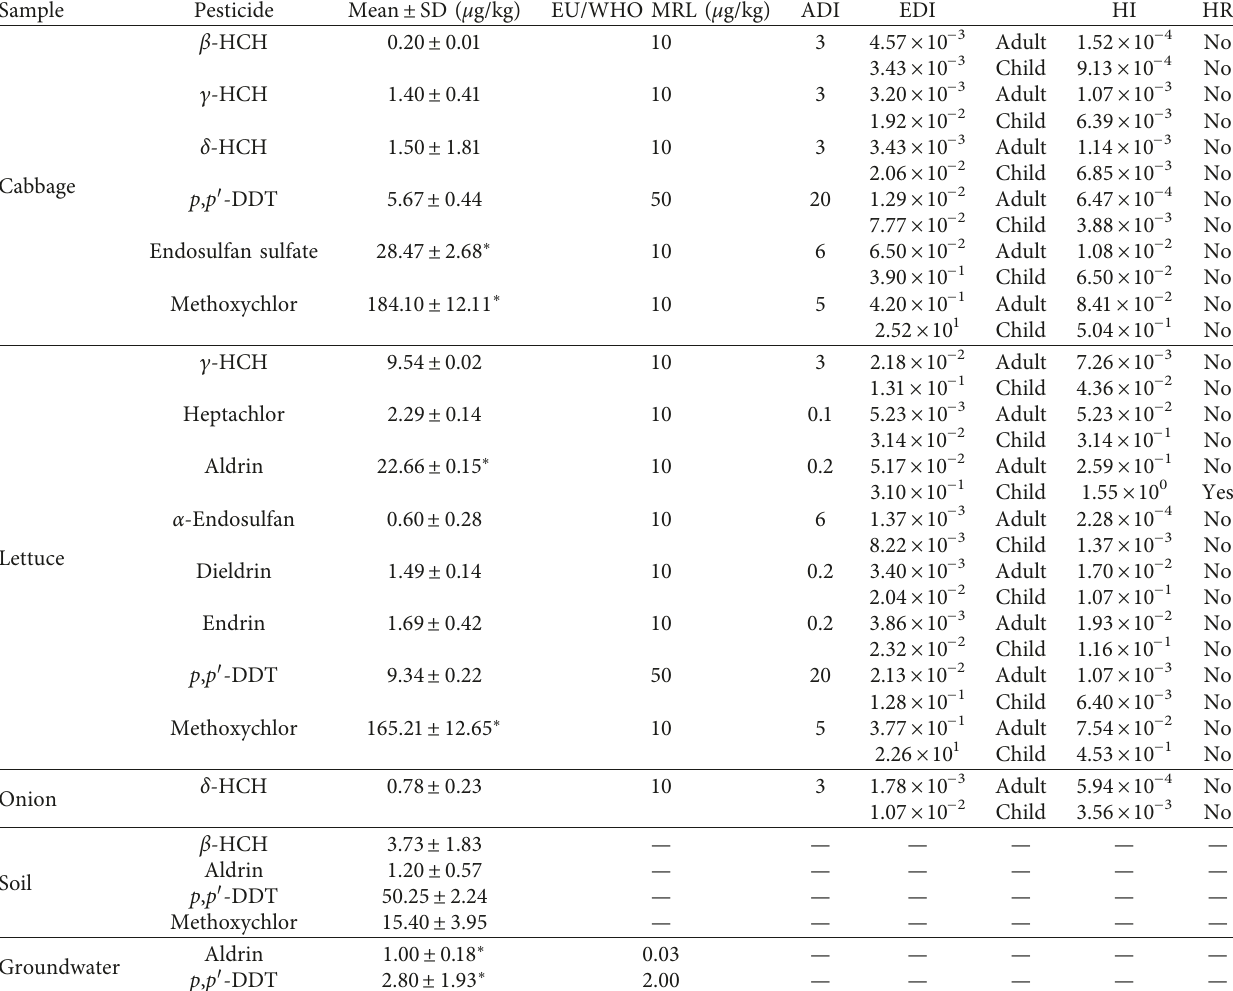
Table 2: Concentrations, EDI, and health risk estimation for OCP residues detected in vegetables from Ayigya. Sample Pesticide